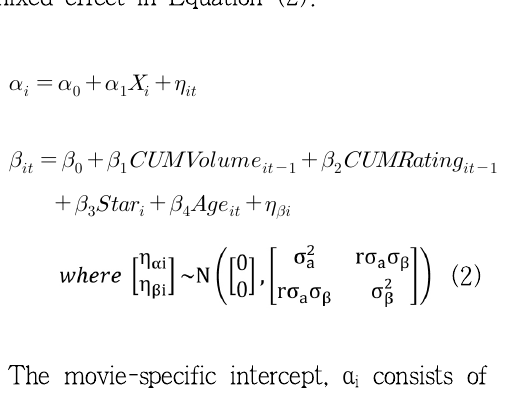
The Effect of Rating Dispersion on Purchase of Experience Goods based on the Korean Movie Box Office Data